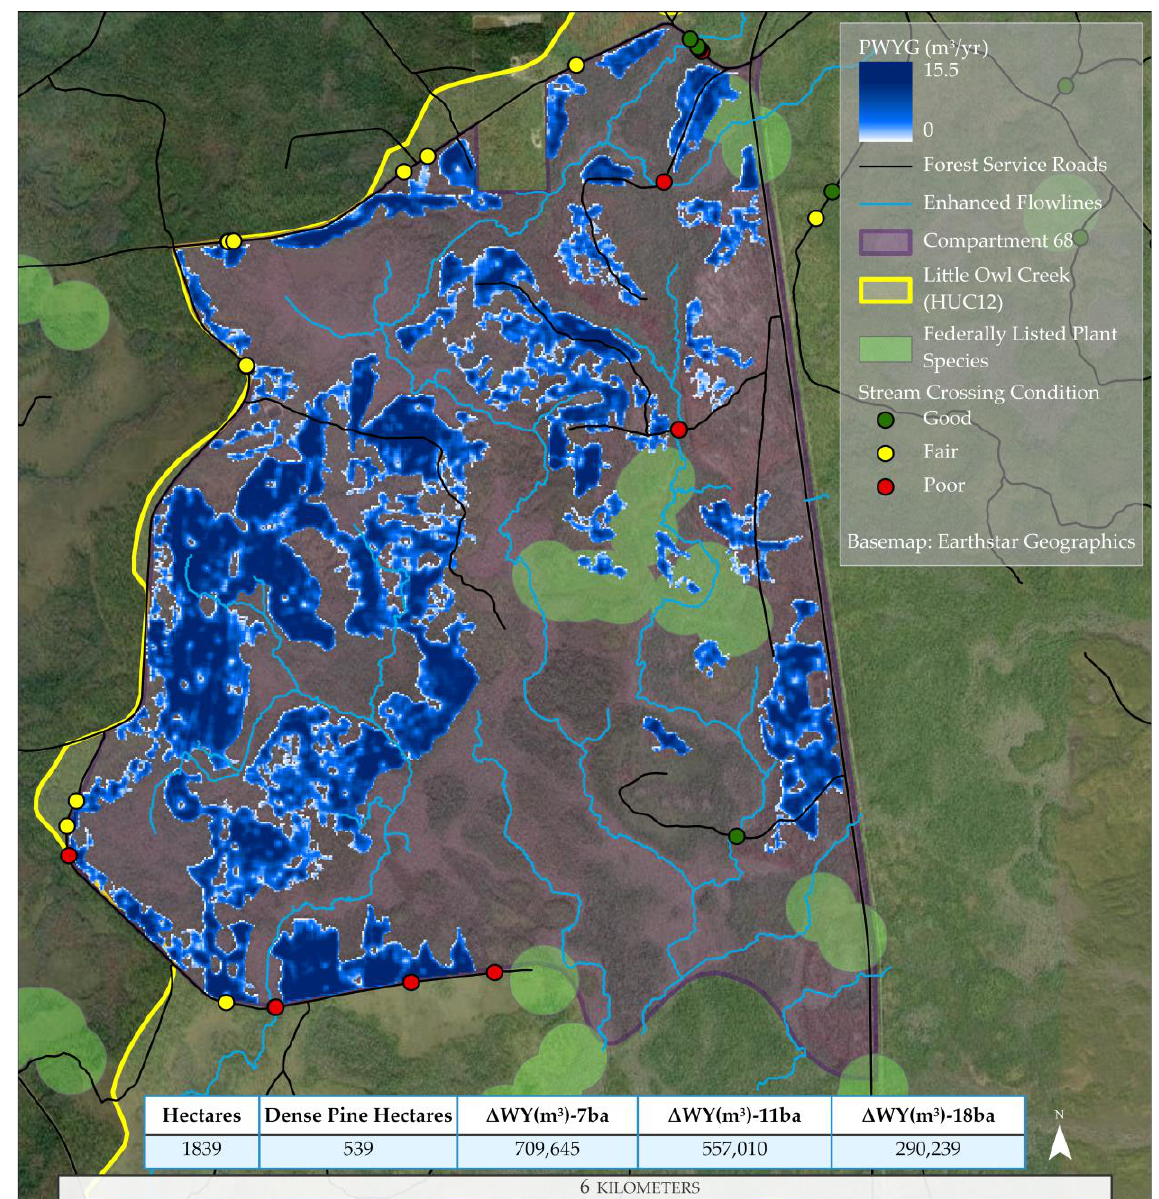
Figure 8. High-resolution view of compartment 68 (shown in purple) on the Apalachicola Ranger District with PWYG in white to blue gradient. Total compartment acres, dense pine BA hectares ( ≥ 18 m 2 ha − 1 ), and PWYG in cubic meters per year in three timber-reduction scenarios—down to 7, 11, and 18 m 2 ha − 1 —are shown in the legend. Also included are 2017 infrastructure condition survey data, enhanced hydrologic flow lines, and general locations of federally listed threatened and endangered